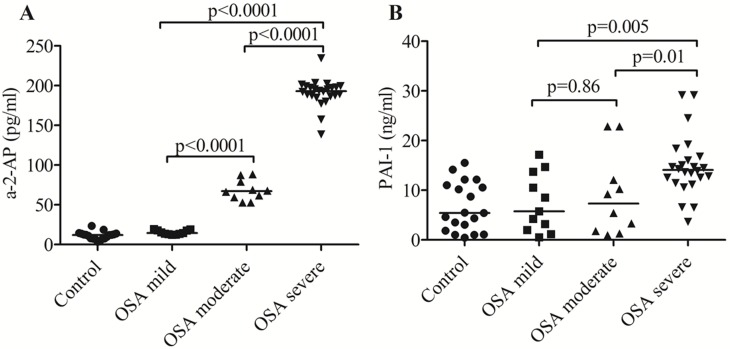
The concentrations of plasma a-2-AP and PAI-1 in the patients with OSA and the control group.The concentrations of alpha-2-antiplasmin and PAI-1 in peripheral blood plasma were determined by enzyme-linked immunosorbent assay (ELISA) in 45 OSA patients and 19 controls. (A) and (B) The concentrations of plasma a-2-AP and PAI-1 in the patients with different grades of OSA severity. Bars represent median value. p values were calculated by the Mann-Whitney test.